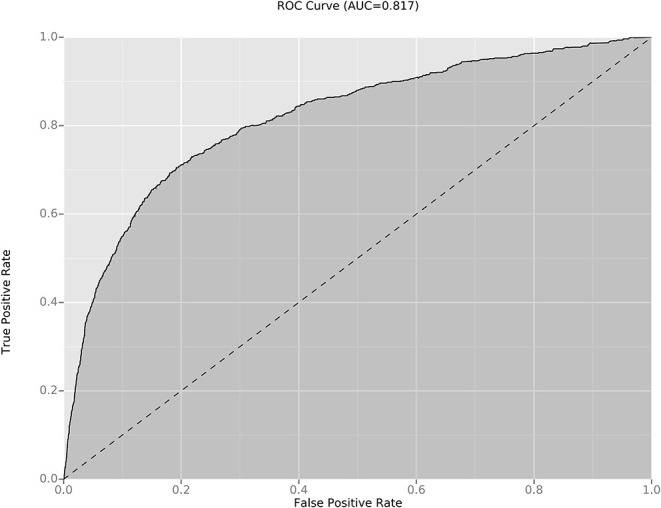
ROC and AUC of the diagnostic models for incomplete KD diagnosis. The AUC value of the new diagnostic model for incomplete KD diagnosis was 0.816. ROC, receiver-operator characteristic curves; AUC, area under the curve.